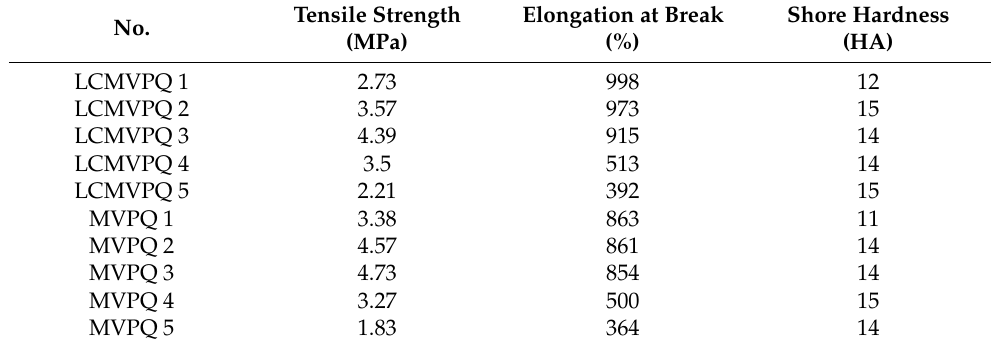
Table 5. Summary of the tensile strength and elongation at break.